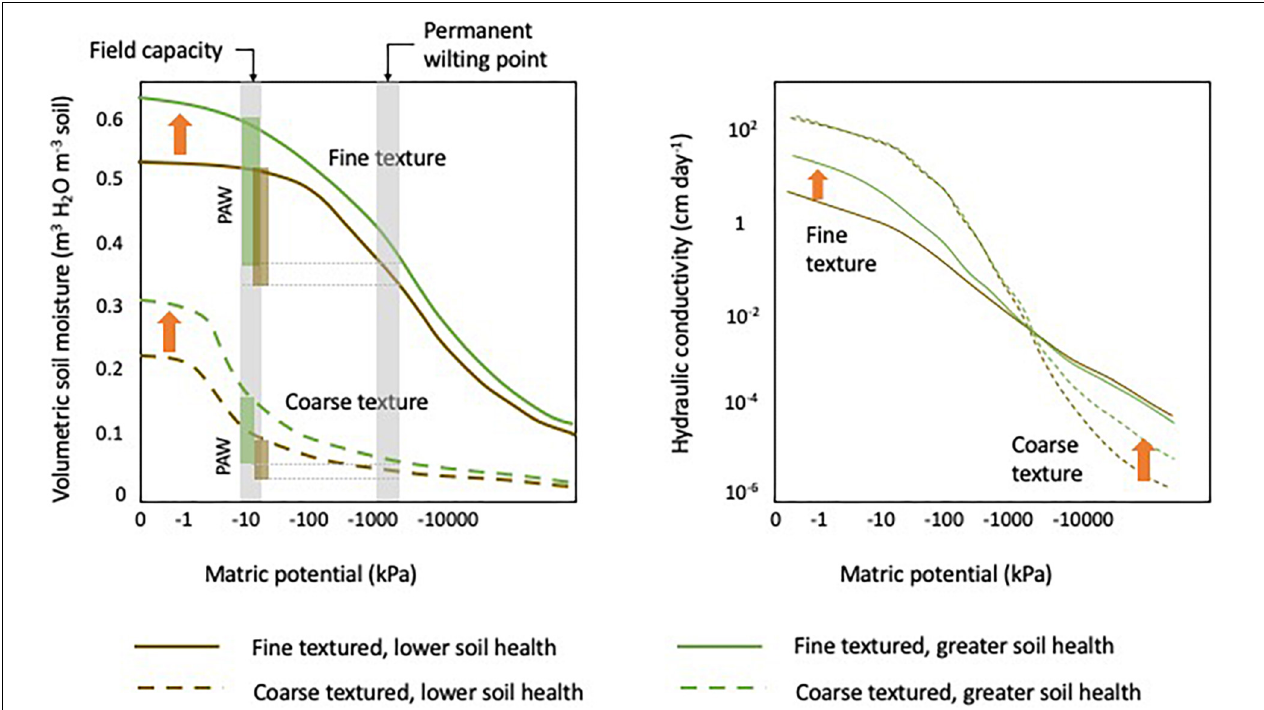
FIGURE 4 | Left: Conceptual representation of soil moisture retention curves for coarse textured soils (dashed line) and fine textured soils (solid lines) soils with lower soil health (brown lines) compared to soils with greater soil health (green lines). Columns represent the amount of plant available water (PAW). Right: Conceptual representation of unsaturated hydraulic conductivity in function of soil matric potential for coarse textured soils (dashed line) and fine textured soils (solid lines) soils with lower soil health (brown lines) compared to soils with greater soil health (green lines). Orange arrows in both figures indicate the direction of improved soil health. Charts modified from Brady and Weil